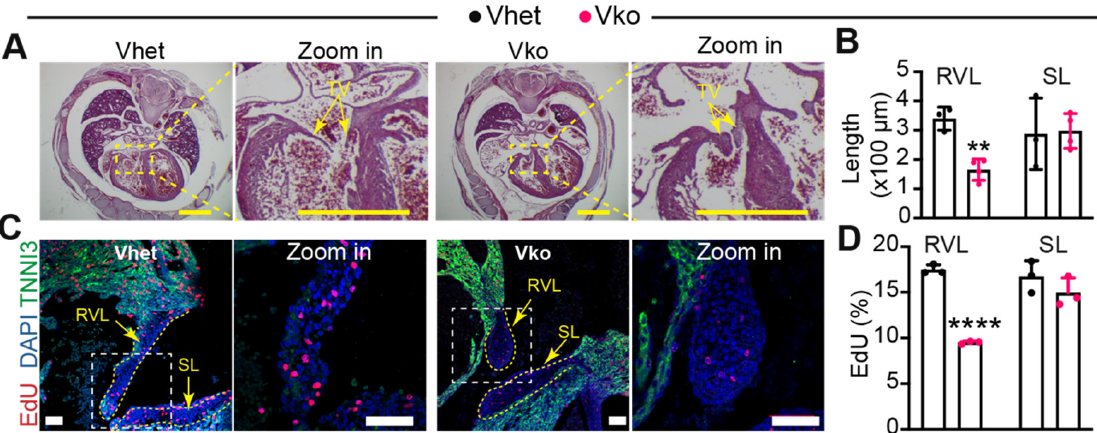
Figure 4. Loss of VGLL4 causes tricuspid valve malformation: ( A ) histology of embryonic heart at E16.5. TV, tricuspid valve. Scale bar = 1 mm; ( B ) measurement of right ventricle side (RV) tricuspid valve leaflet length and septal leaflet length. N = 3–4; ( C ) representative immunofluorescence images of tricuspid valve at E16.5. Scale bar = 50 µm. RVL, right ventricle side tricuspid valve leaflet. SL, septal leaflet; ( D ) EdU incorporation rate of tricuspid valve interstitial cells. ( B , D ), Student’s t -test: ** p < 0.01; **** p < 0.0001. N = 3. A and C, arrows indicate tricuspid valve leaflets.